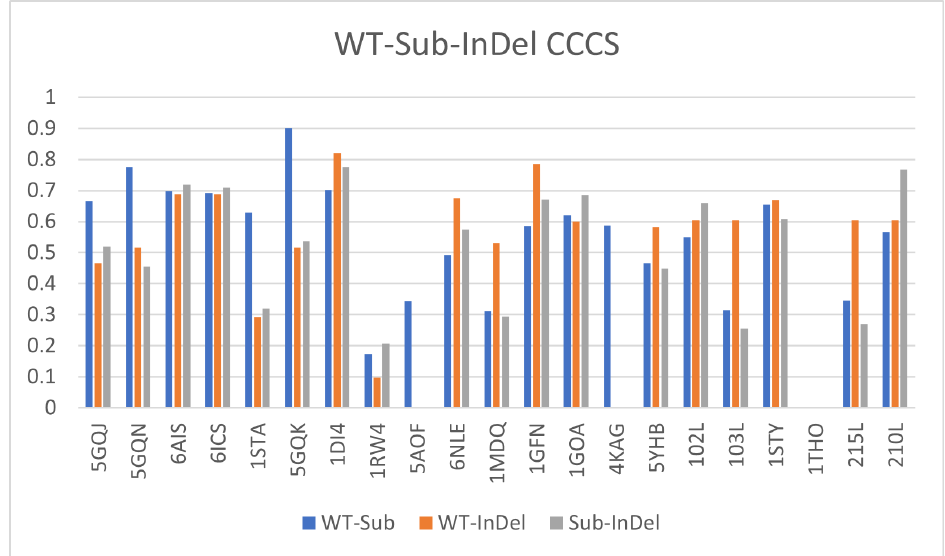
Figure 7. Graph showing the TLCCS between each pair of the wildtype–substitution (blue bar), wildtype–InDel (orange bar), and substitution–InDel (gray bar). Lower scores indicate a greater difference between their largest two rigid